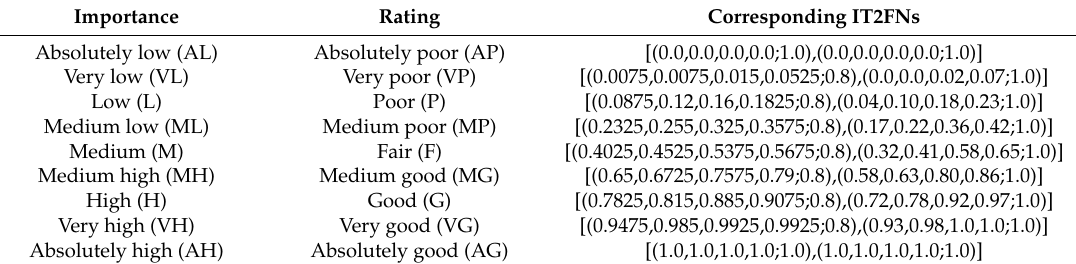
Figure 3. Flow diagram of the proposed approach. IT2FNs: interval type-2 fuzzy numbers, MABAC: multi-attributive border approximation area comparison. Table 2. Linguistic variables and their corresponding IT2FNs.